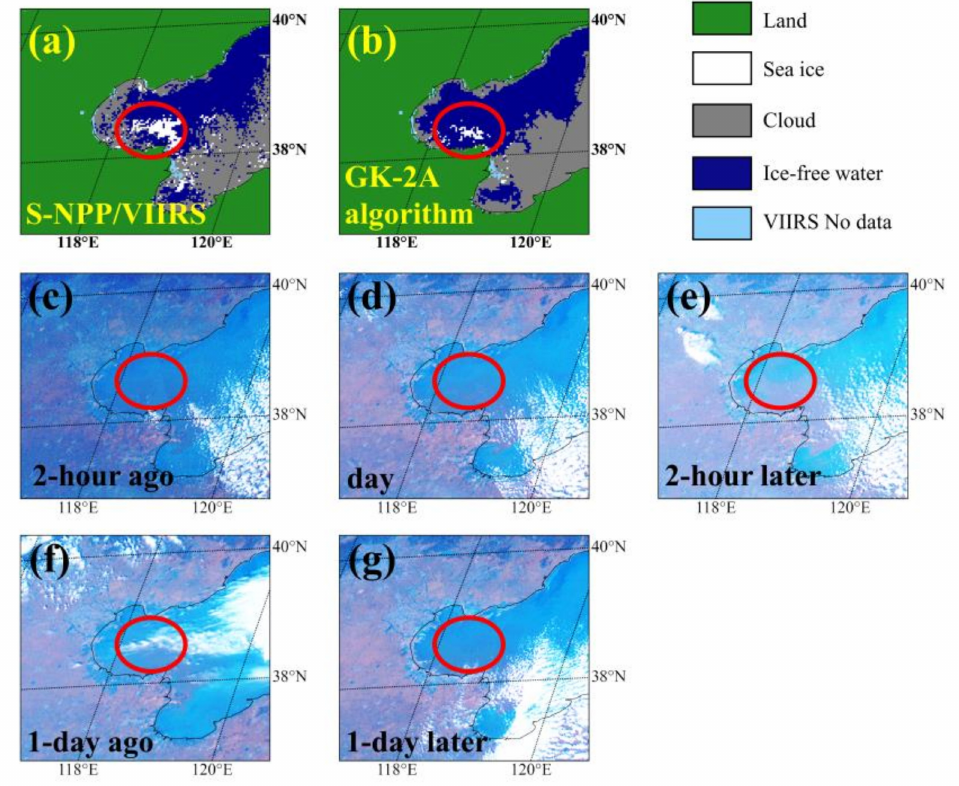
Figure 12. ( a ) S-NPP / VIIRS SIC EDR data at 03:53 UTC, 10 January 2018, ( b ) sea-ice data